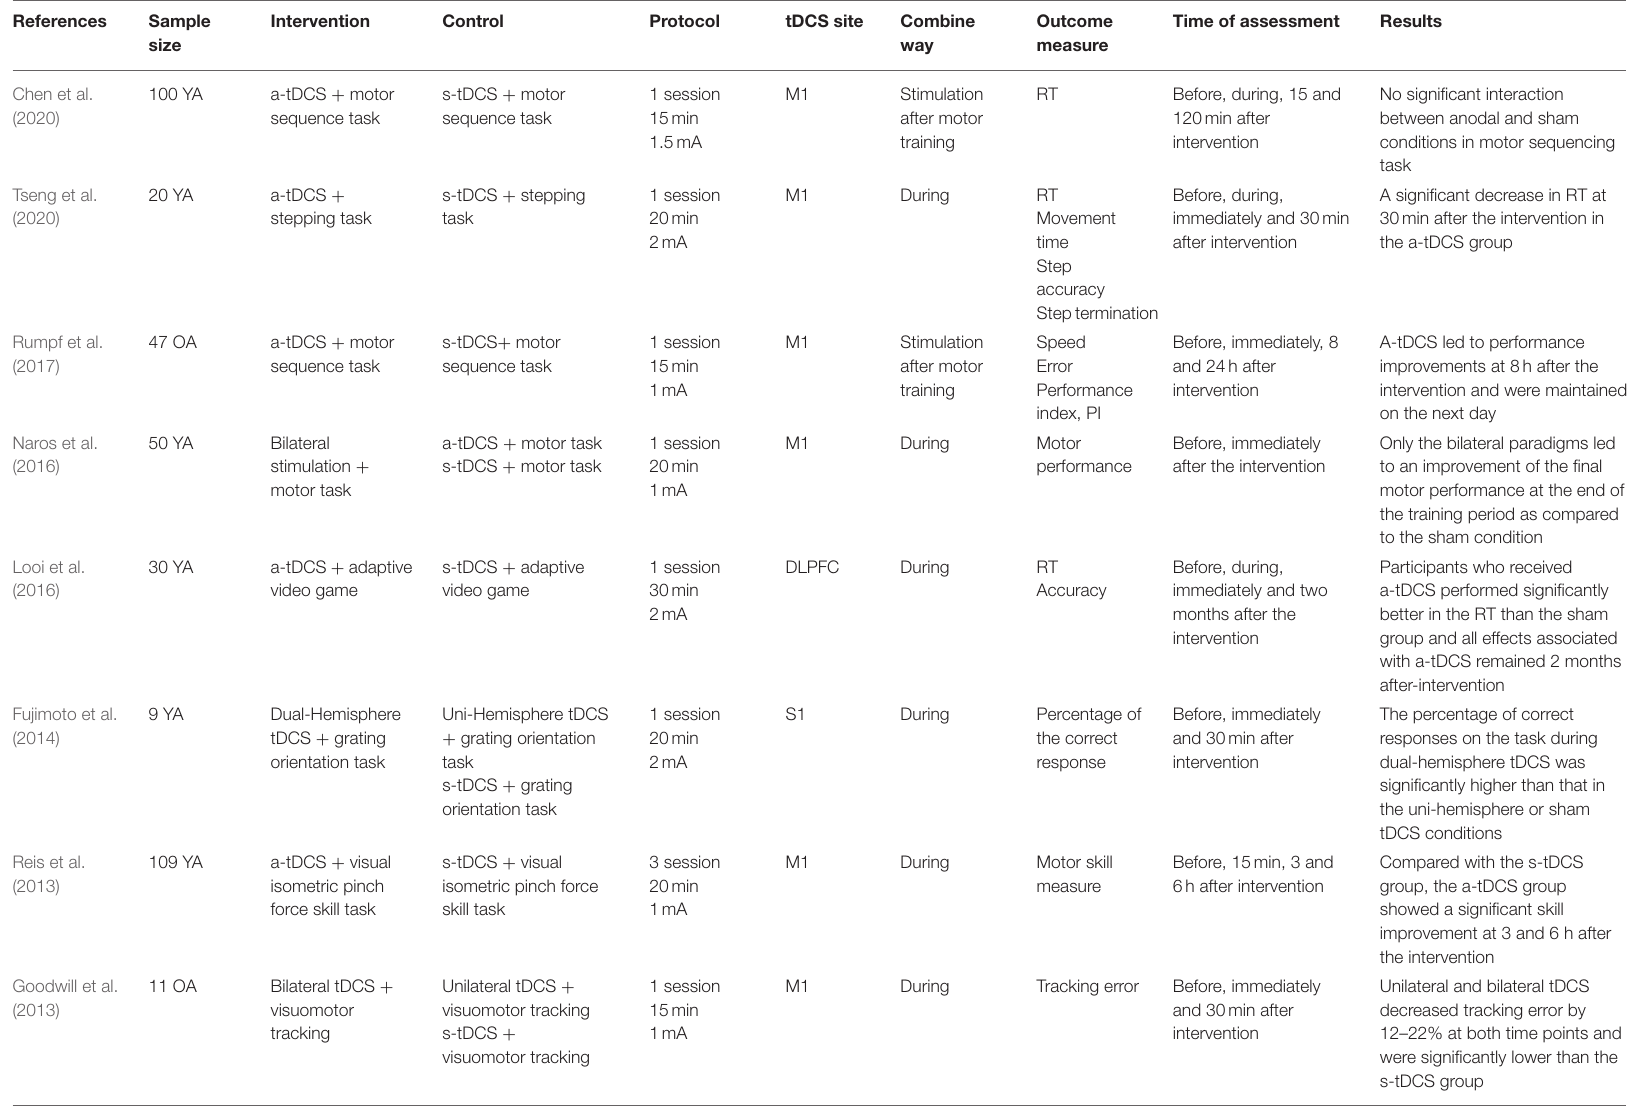
TABLE 3 | The effects of tDCS combined with physical training on motor